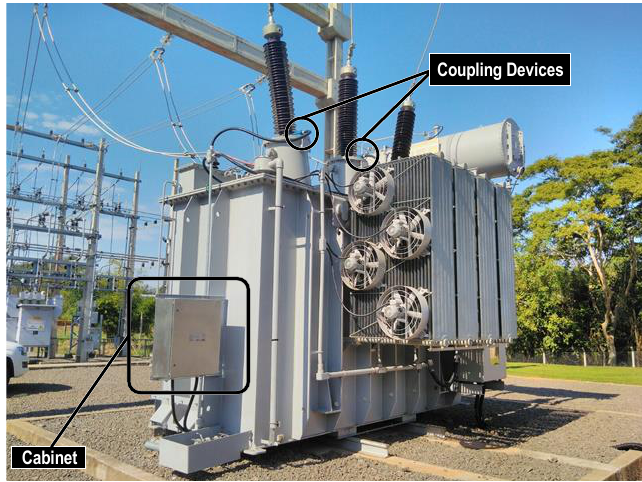
Figure 19. Online monitoring system installed in a 30 MVA power transformer.